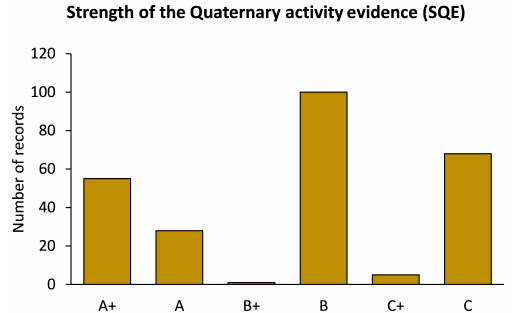
Figure 2. Distribution of level classes of strength of the Quaternary activity evidence (SQE) in QAFI v.3 database. See text for further